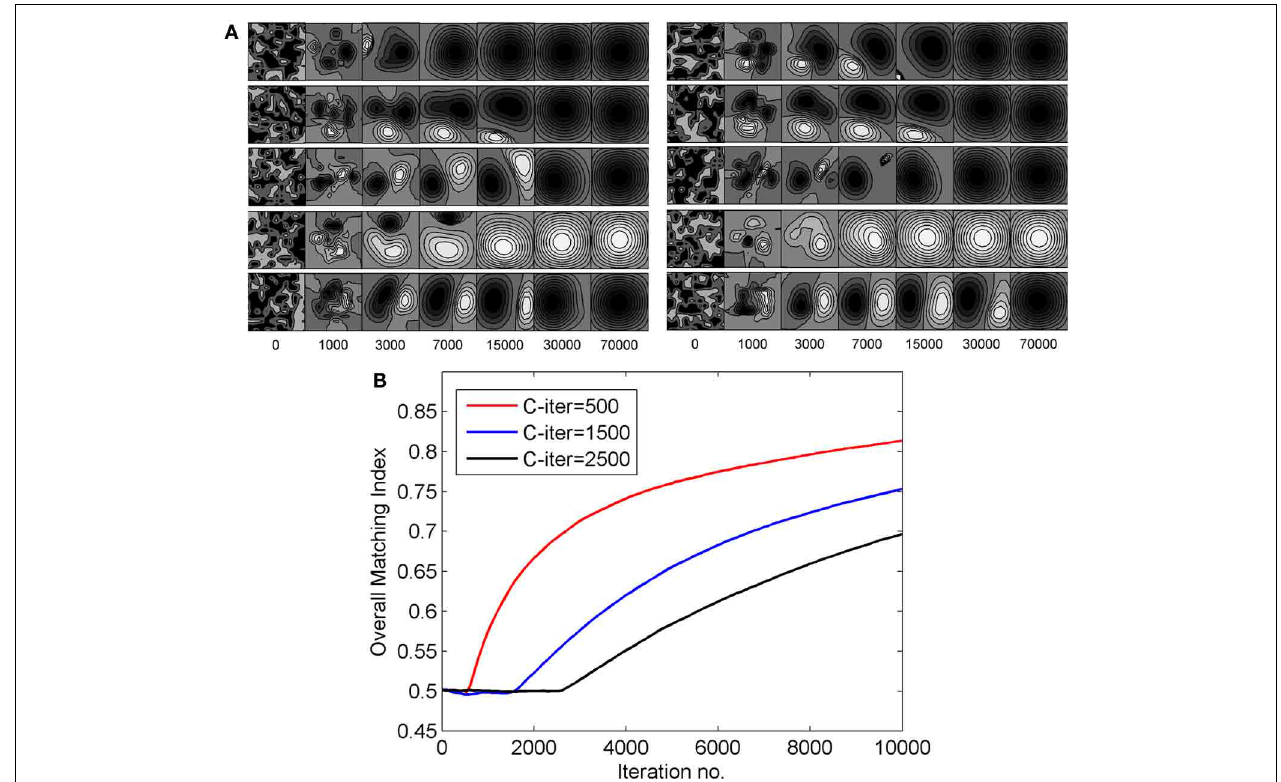
FIGURE 9 | (A) The effect of extending the duration of critical period on RFs. The left eye and the right eye specific RFs for some sample cells are shown. The RFs shown on the left of the figure are for the left eye